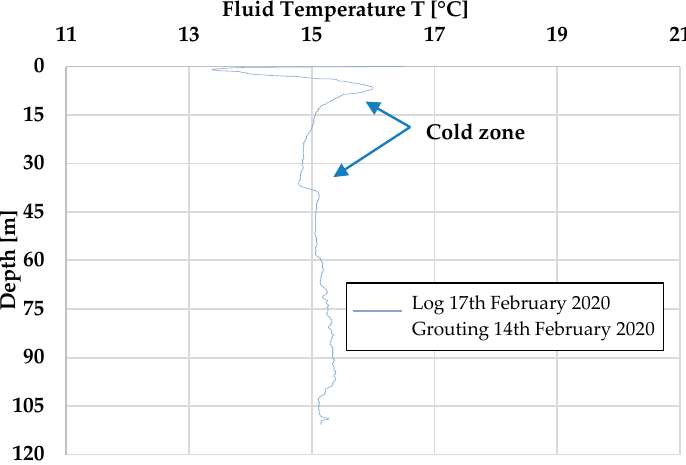
Figure 8. Vertical ground temperature profiles at the ASC-2 BHE during the grout hydration period. A “cold zone” appears in the last 40 m.